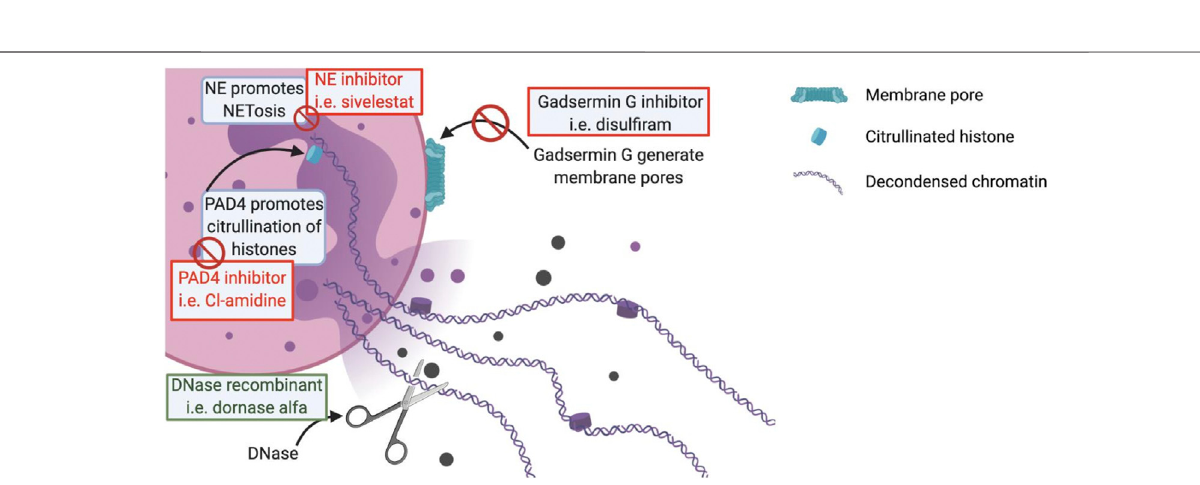
Frontiers in Pharmacology |